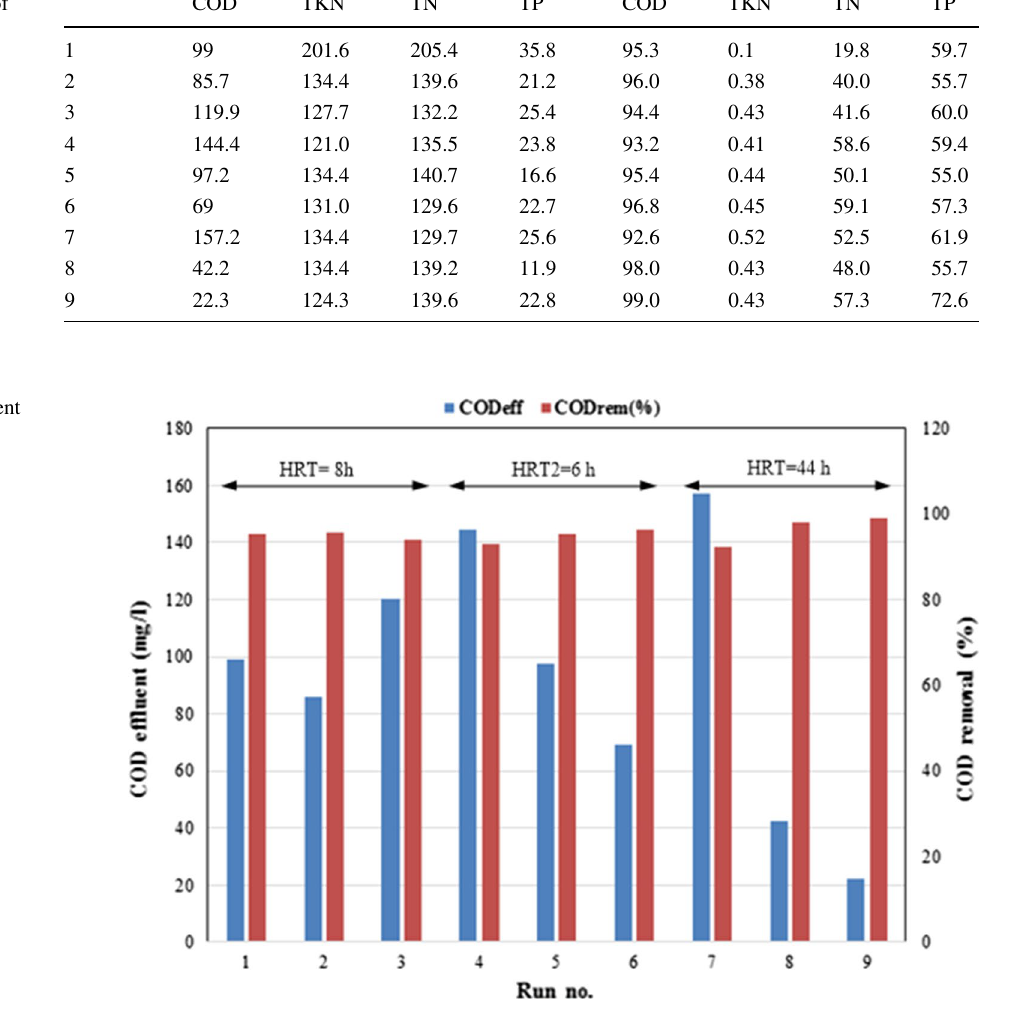
Table 3 The average removal efficiency of the main physicochemical parameters of the bioreactor effluent